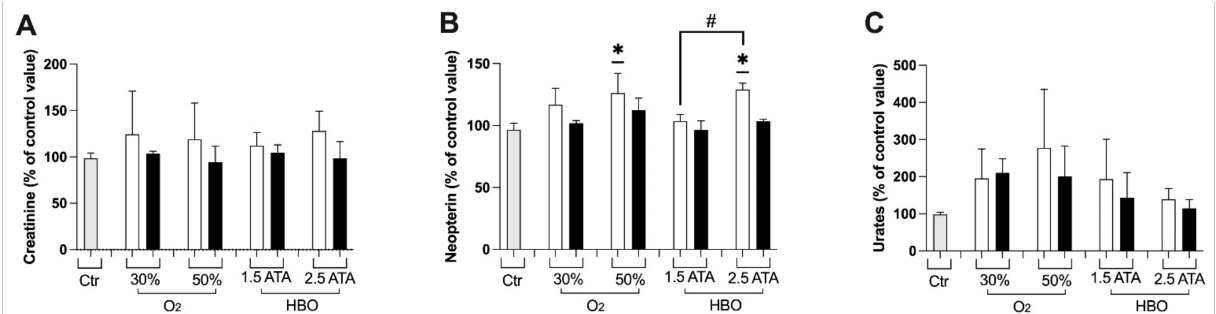
Figure 3. Histogram plot (% ± SD) of renal function biomarkers: ( A ) Creatinine, ( B ) Neopterin and ( C ) Urates. The control group (Ctr) is reported in grey; white and black bars identify T1 and T2, respectively. Significant difference intra-group: * p < 0.05. Significant difference between groups: # p <